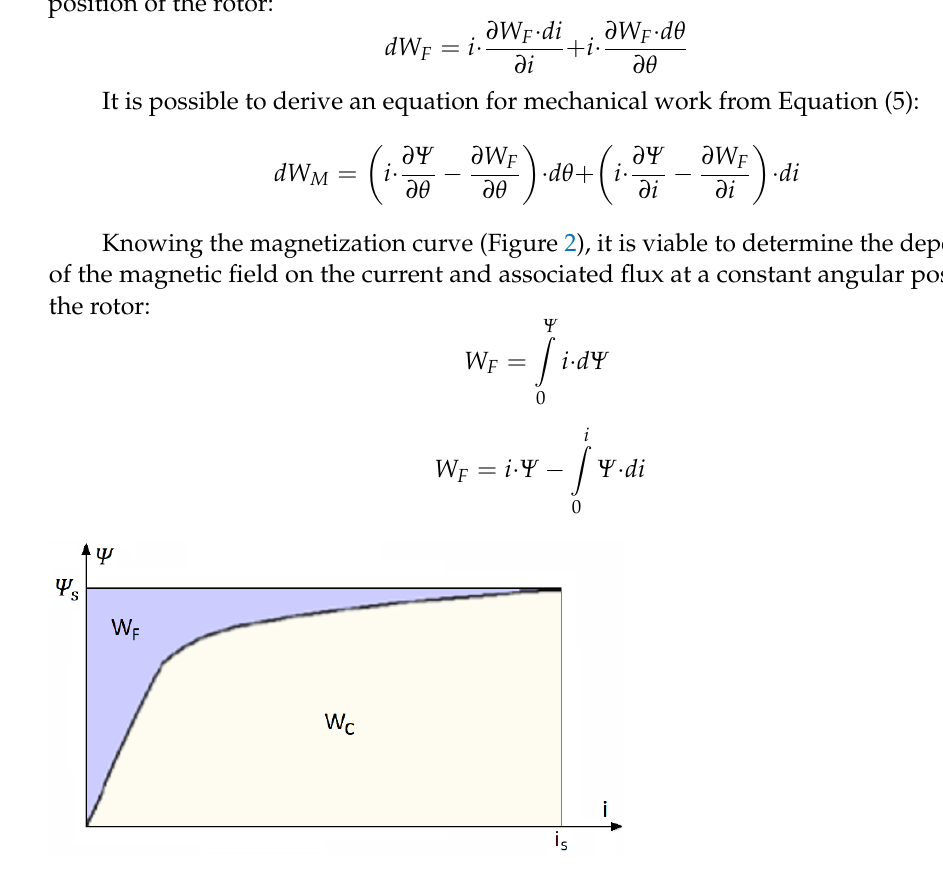
Figure 2. The course of the associated flux ψ s at the position of the rotor in the coaxial position, illustrating the energy of the magnetic field W F and co-energy W c .